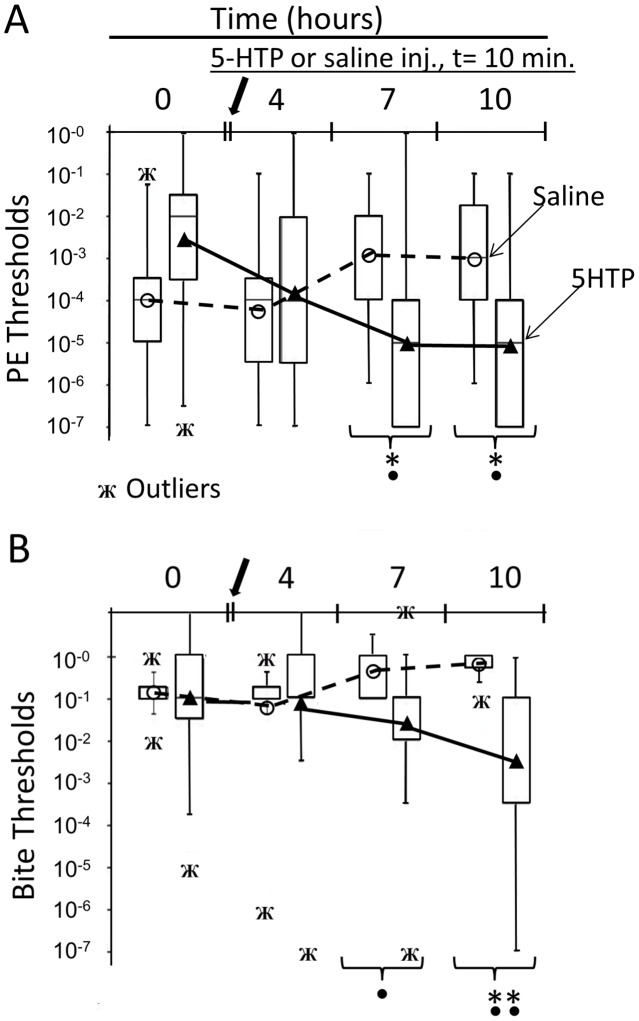
5-HTP injection reduced thresholds for both proboscis extension (A) and biting (B).Following initial threshold measures at t = 0 with squid homogenate dilutions, animals were injected with 5-HTP (50 µM estimated internal dilution) at t = 10 min. (○, group mean experimentals; N = 15) or isotonic saline (▴, group mean controls; N = 8) and measured at intervals over 10 hours. Proboscis extension (PE) and bite thresholds differed significantly over trials in the 5-HTP injected groups (Friedman's non-parametric repeated measures ANOVA, χ2 = 21.744 (PE), χ2 = 12.830 (Bite), p<0.0001 and p<0.005, respectively). Experimentals' PE thresholds were significantly reduced starting at 7 and 10 hours (Wilcoxon matched-pairs signed-ranks tests: W = −101, *p<0.0005). Bite thresholds were significantly reduced at 10 hours (**p<0.0001). 5-HTP injected experimentals differed over time from saline injected controls (Kruskal-Wallis Non-parametric ANOVA, H = 19.315 (PE), H = 14.838 (Bite), p<0.01 and p<0.04 for PE and Bite thresholds, respectively). Threshold differences between experimentals and controls were significant at 7 and 10 hours (Mann-Whitney tests, •p<0.02). Bite threshold increased over the experiment in saline injected controls (Friedman's non-parametric repeated measures ANOVA, χ2 = 8.882, p<0.02), suggesting handling effects [16], but the individual increases were non-significant.